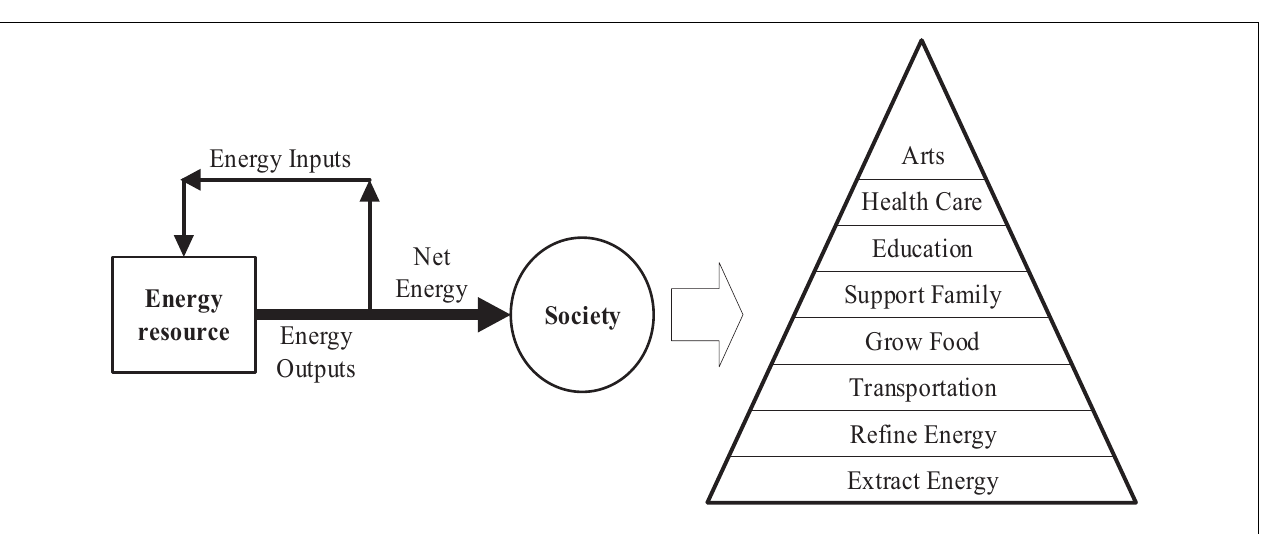
FIGURE 1 | Energy resource exploitation from a material perspective.